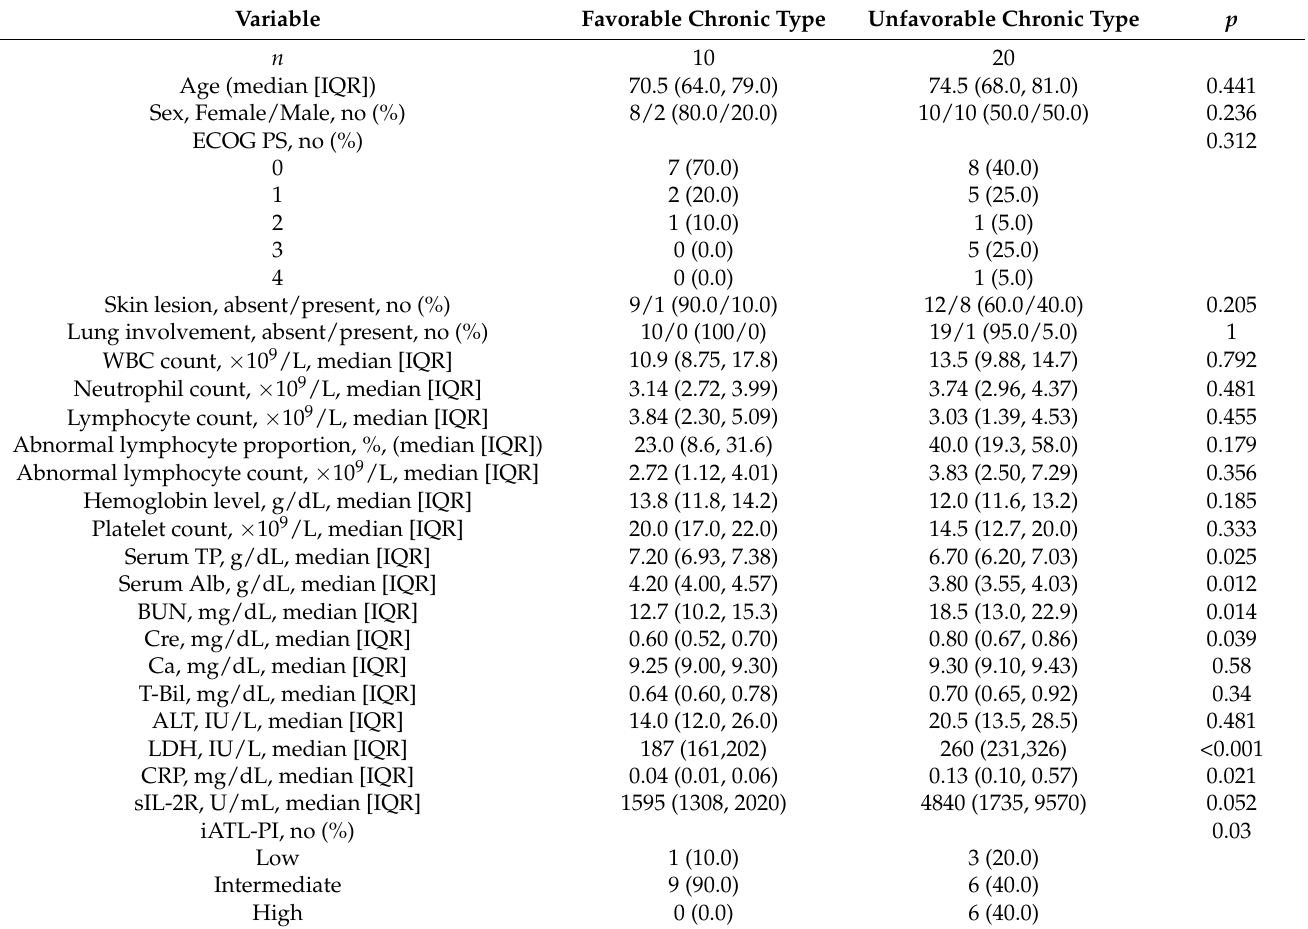
Table 2. Clinical characteristics of chronic-type adult T-cell leukemia/lymphoma ( n =